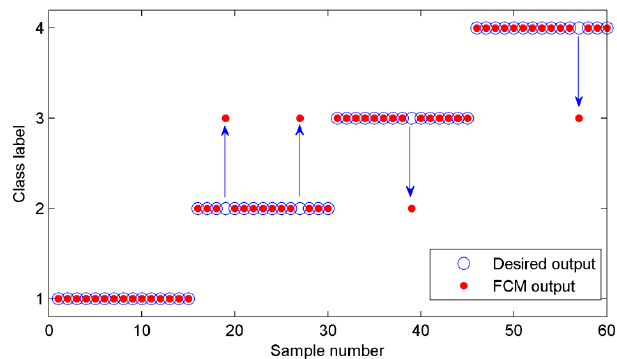
Figure 8. The classification results of FCM clustering without reprocessing method.